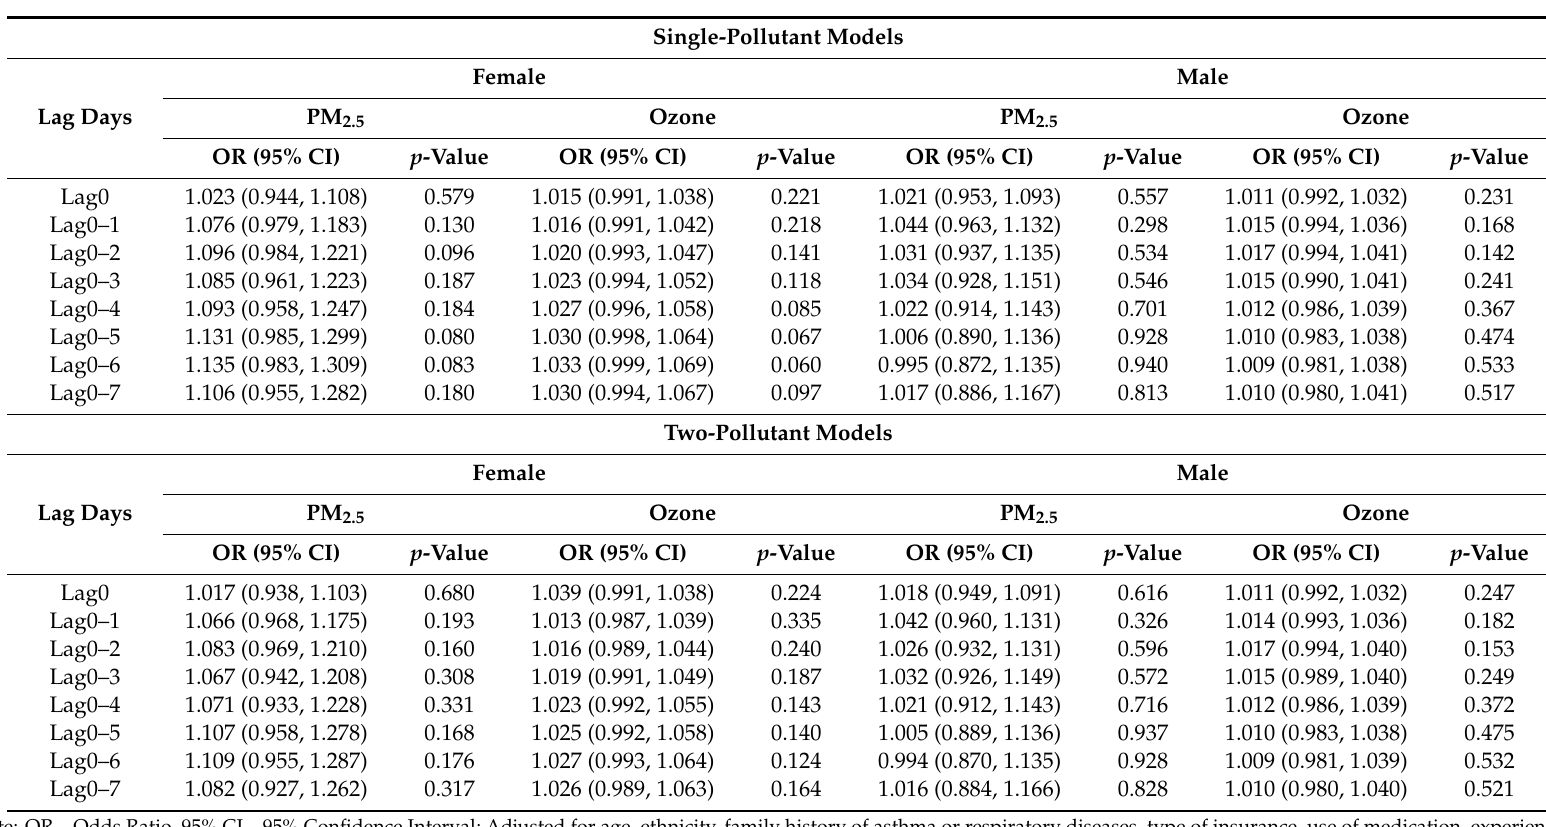
Table 5. Results of multivariate binomial logistic regression analysis stratified by gender in single- and two-pollutant